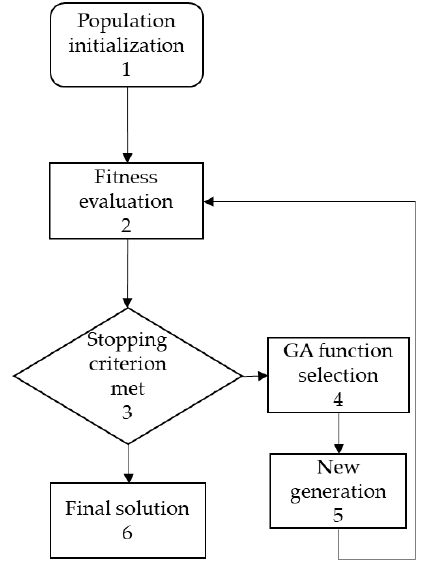
Figure 6. Flowchart for the GA optimization.